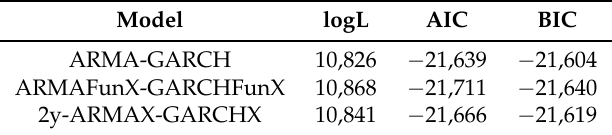
Table 3. logL, AIC and BIC, corresponding to the full models from Table 1.